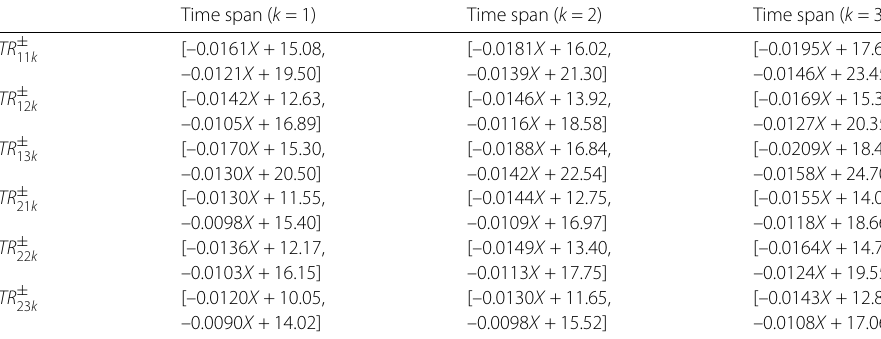
Table 3 Waste transportation cost (in dollars)